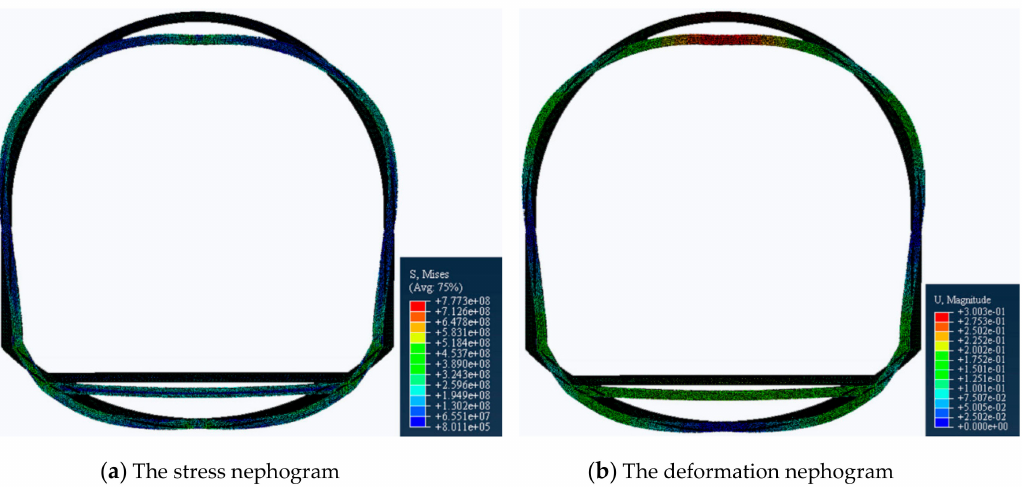
Figure 15. The stress nephogram and the deformation nephogram of FB set